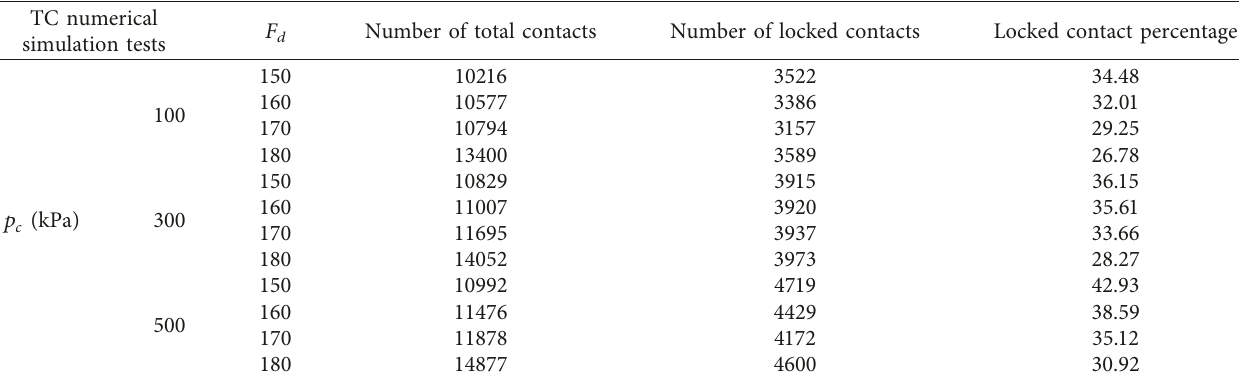
Table 3: Percentage of locked